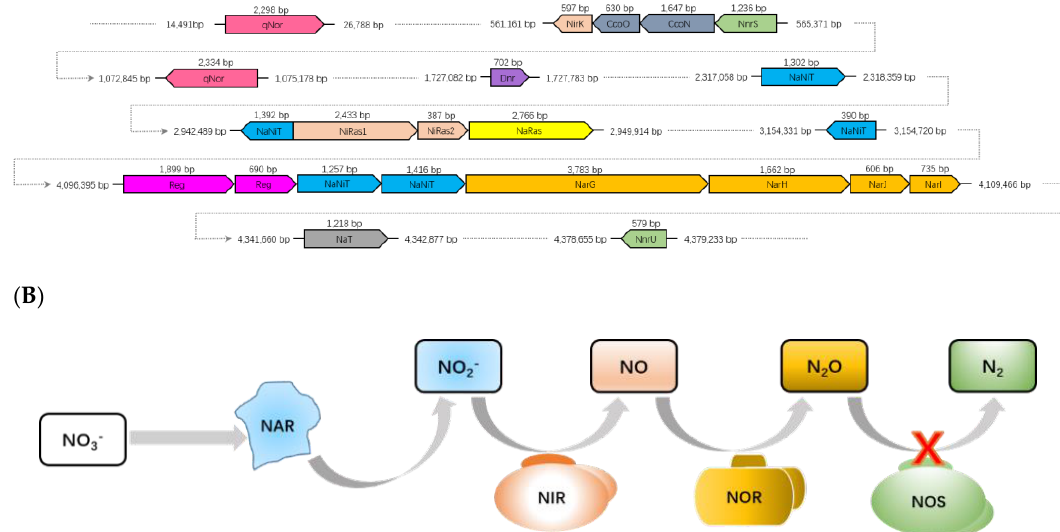
Figure 5. ( A ) Denitrification gene clusters located on draft genome of strain CHu59-6-5 T . Color key: pink, nor genes; light orange, nir genes; blue-grey, cco genes (cytochrome c oxidase subunit); green, nnr genes (NO sensing protein (NnrS); denitrification regulatory protein (NnrU); white, dnr gene (NO responding transcriptional regulator); blue, naNiT genes (nitrate/nitrite transporter); yellow, naRas gene (nitrite reductase [NAD(P)H] large subunit (NaRas1), Nitrite reductase [NAD(P)H] small subunit (NaRas2); purple, reg genes; gold, nar genes; grey, naT gene (nitrate ABC transporter). ( B ) The substance transformation in the denitrification process was identified from the genome.